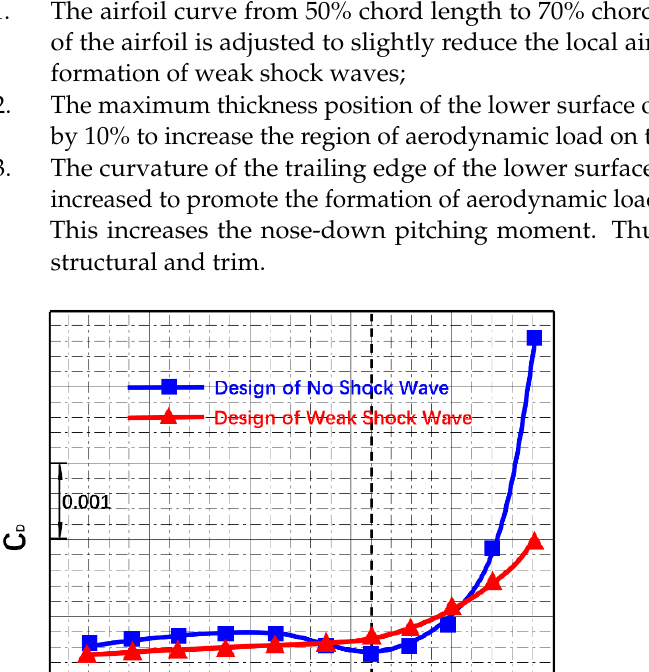
Figure 24. Result of airfoil design. 4.2. Design Results The calculated states used by OLD and NEW are listed in Table 7. The results of the C p curve in the central experimental wing are displayed in Figure 25. These results show that a weak shock wave appears at 50% chord length of the NEW airfoil at α = 2°. The C p shape in front of the shock wave of the NEW does not change significantly compared with the C p curve of OLD . However, the value of C p decreases, which benefits the increase in the C L . The position of the negative pressure peak is moved from 60% to 50% of the chord direction, which further increases the aerodynamic load on the rear part of the airfoil. The aerodynamic load after a 50% chordwise position on the lower surface of the NEW airfoil is obvious. Therefore, the whole area enclosed by the C p curve is significantly increased. In short, the shape of the C p curve matches well with the design intent. In addition, the favorable pressure gradient segment from the leading edge of the airfoil to 50% of the chord length on the OLD upper surface is well inherited by NEW . This determines the laminar flow characteristics of the NEW on the upper surface. It can be found in Figure 26